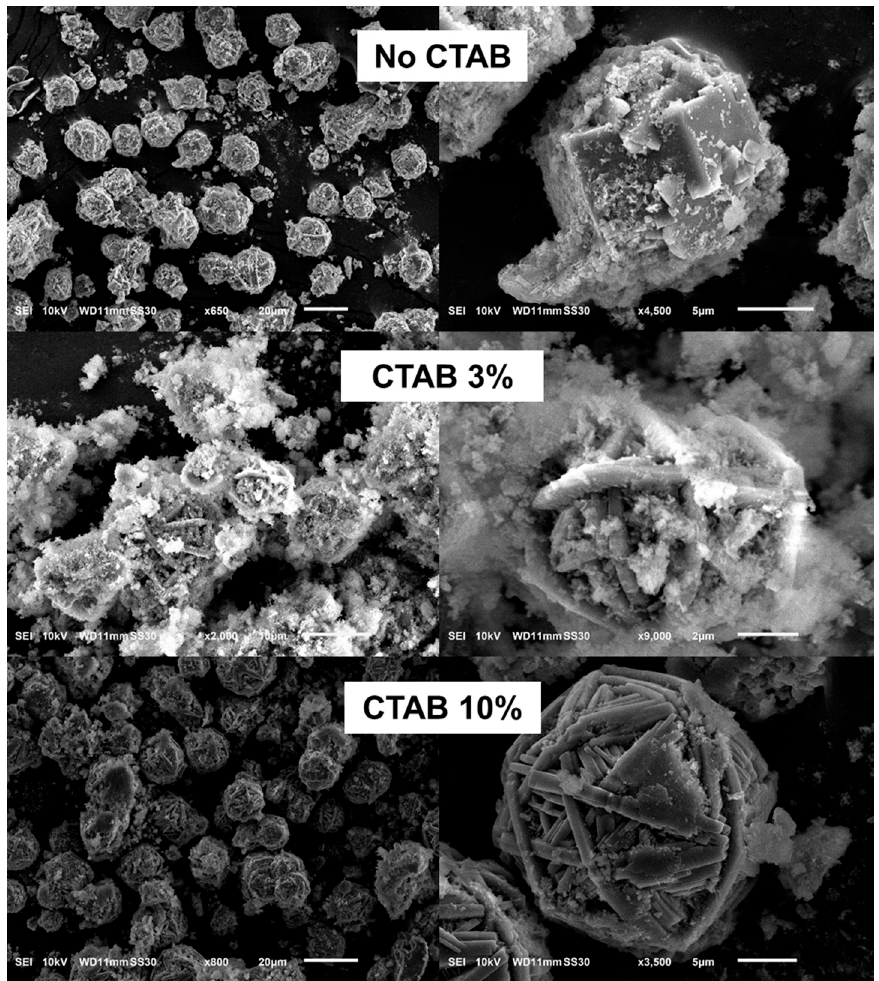
Figure 7. SEM images of hydrothermally treated DE: no CTAB ( top row ); 3 wt. % CTAB ( middle row ); 10 wt. % CTAB ( bottom row ).